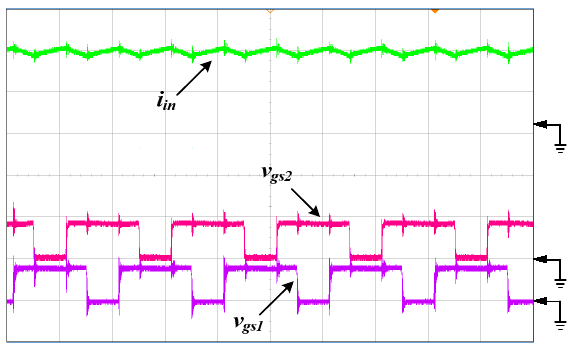
Figure 6. Experimental waveforms of input current and corresponding control signals ( i in : 5 A/div, v gs1 and v gs2 : 20 V/div, time: 10 μ s/div).